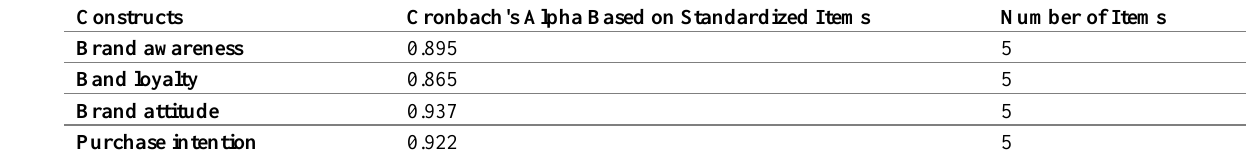
Table 3: Assessment of the